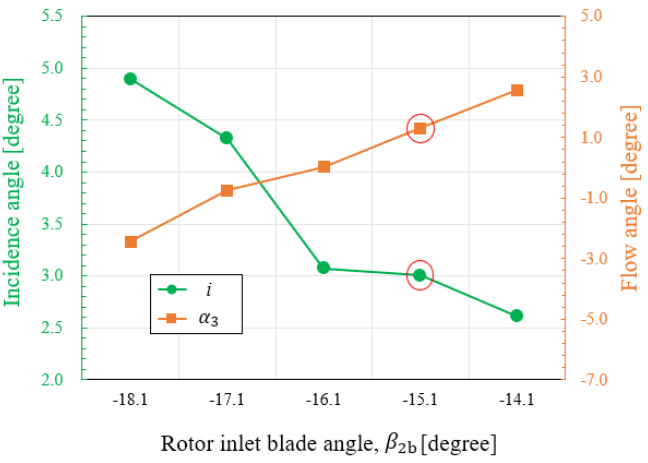
Figure 15. Incidence angle ( i ) and flow angle ( α 3 ) according to the second-stage rotor optimization of the radial outflow turbine.